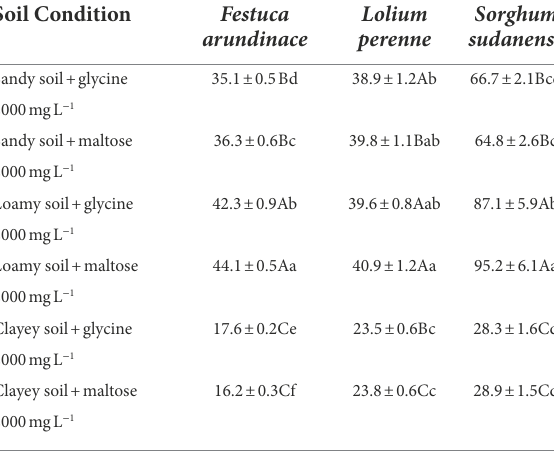
TABLE 6 Degradation rates of total petroleum hydrocarbons under different soil conditions (%).